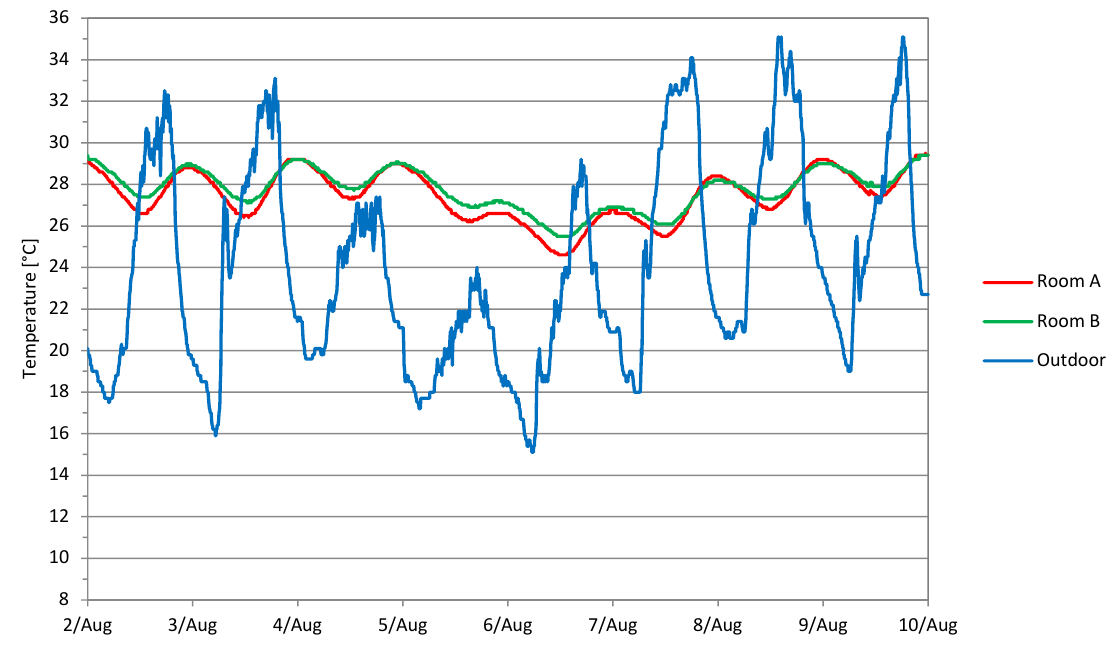
Figure 18. Indoor temperature in room A and room B as well as outdoor temperature during the summer, 2 through 9 August 2018.